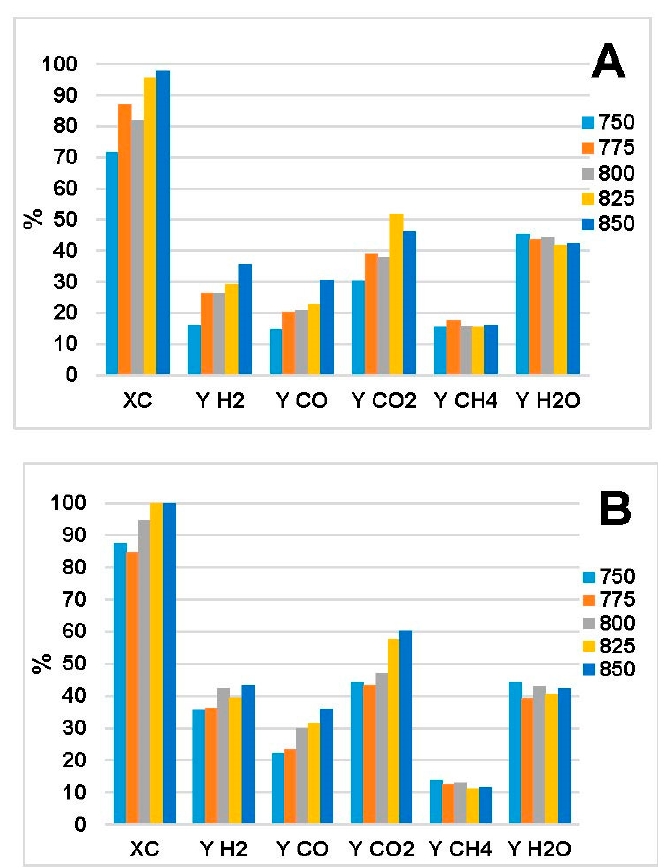
Figure 2. Bio-oil WU results: ( A ) WHSV = 7.1 g/g cat /h; and ( B ) WHSV = 1.8 g/g cat /h.